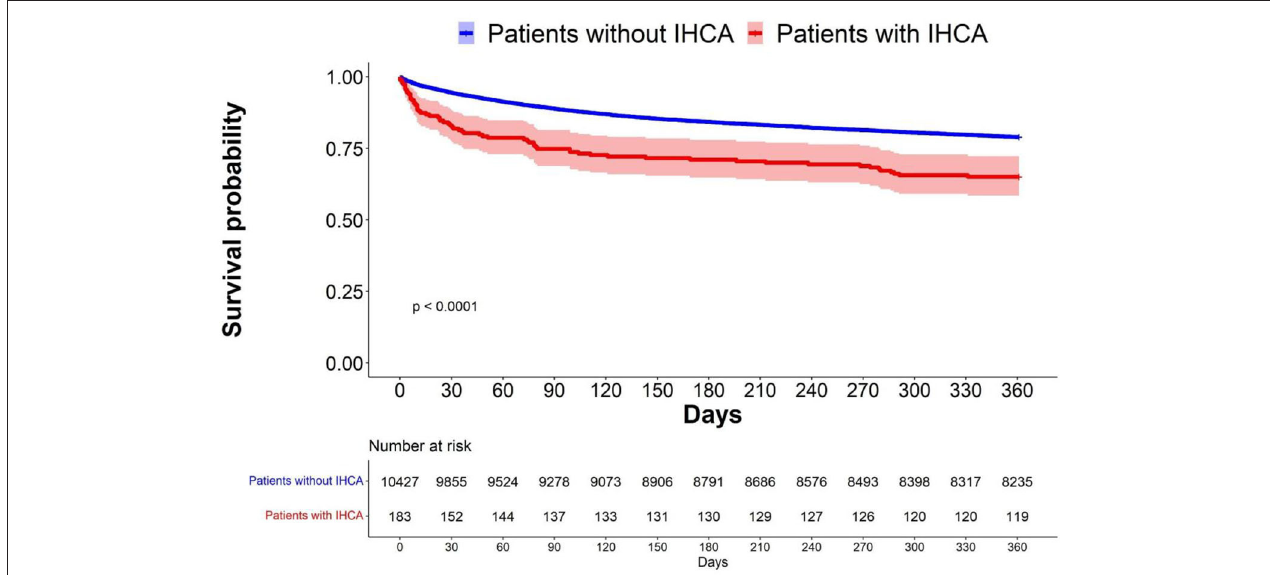
FIGURE 3 | Survival probability before PS weighting.The Kaplan-Meier survival curve showed the survival probability with and without IHCA before PS weighting.